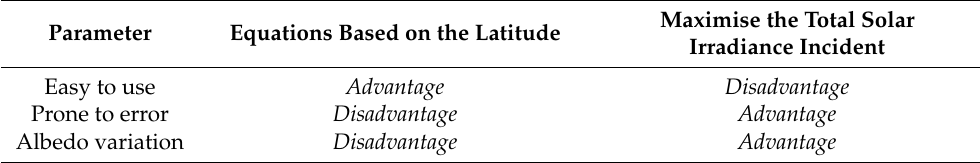
Table 1. Advantages and disadvantages of procedures to find optimum tilt angle. Parameter Equations Based on the Latitude Easy to use Advantage Prone to error Disadvantage Advantage Albedo variation Disadvantage Advantage